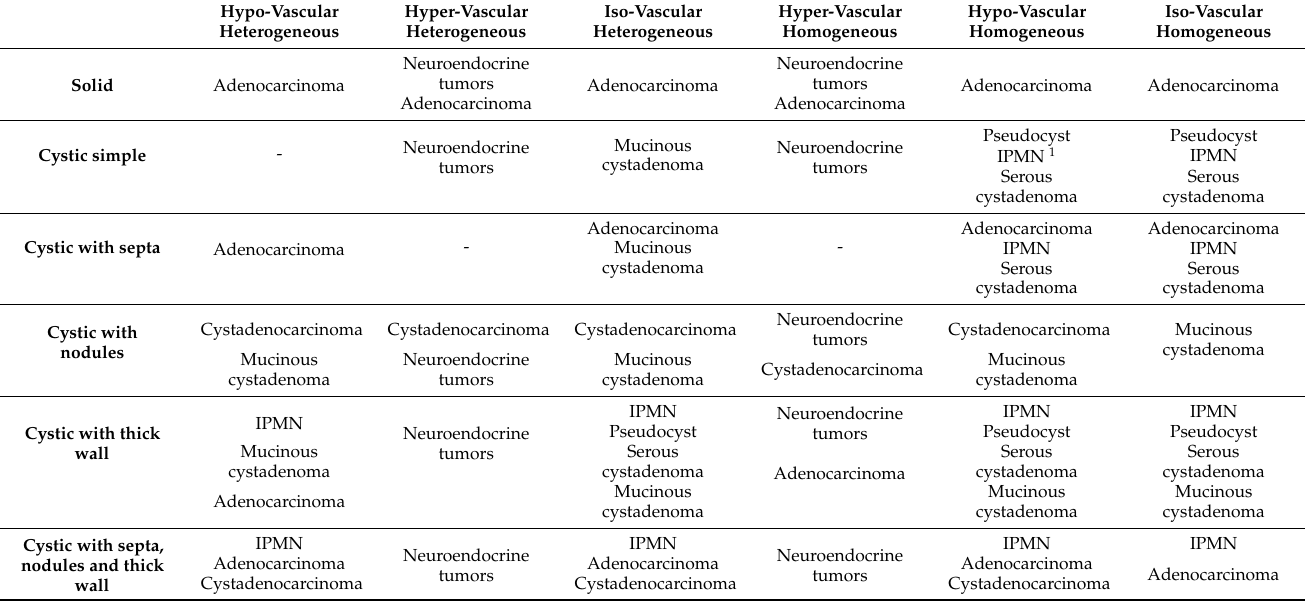
Table 2. Features and enhancing pattern of focal pancreatic lesions in